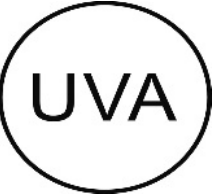
Figure 1. Symbol used for products compliant with the requirement of UVA protection and minimum Critical Wavelength of 370 nm.